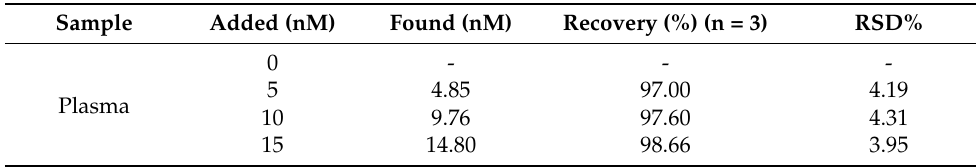
Table 2. Epirubicin determination in plasma Table 2 . Epirubicin determination in plasma sample.